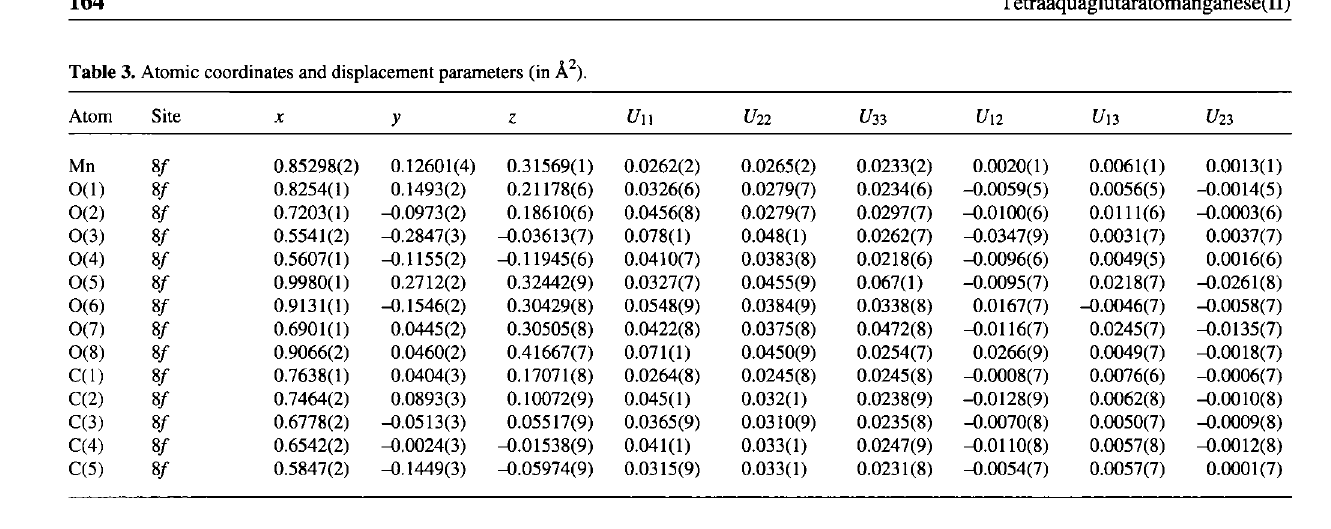
Table 3. Atomic coordinates and displacement parameters (in Ä 2